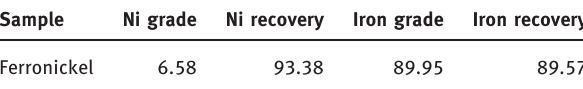
Table 2: Grades and recoveries of Ni and iron of ferronickel com- pared to raw mineral